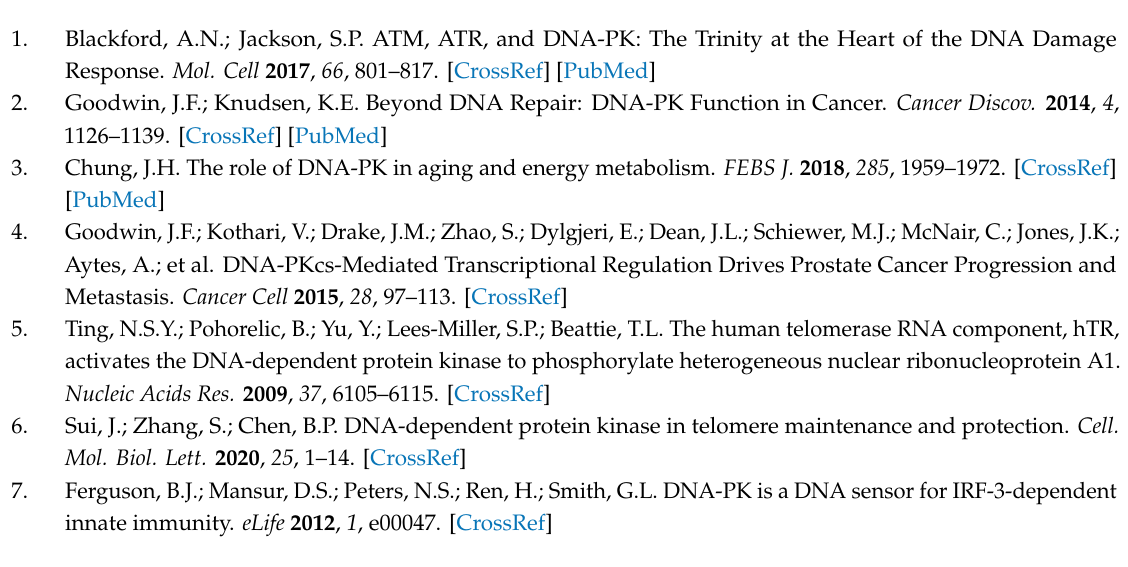
Table S1: DAVID functional annotation of DNA-PKcs targets, Table S2: Enriched biological processes and molecular functions in DNA-PKcs targets